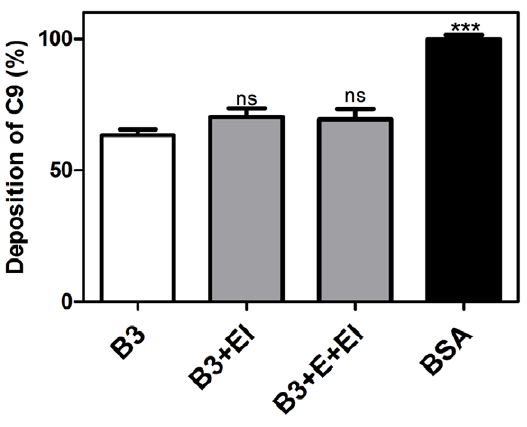
Figure 8. Digestion of SMSB3 by human neutrophil elastase has no effect on C9 deposition. SMSB3 was cleaved with human leukocyte elastase, following which the enzyme was inhibited by addition of N -methoxysuccinyl-Ala-Ala-Pro-Val-chloromethyl ketone. Control reactions without addition of elastase (E) and elastase inhibitor N -methoxysuccinyl-Ala-Ala-Pro-Val-chloromethyl ketone were pre- formed under the same conditions. Mannan was immobilized on microtiter plates and allowed to activate 4% NHS containing 50 m g/ml SMSB3. As a negative control, BSA was used at a concentration of 10 m g/ml. After a 20 min incubation the plates were washed and the deposited C9 was detected with specific antibodies. An average of three independent experiments is presented with bars indicating means 6 SEM. *p , 0.05, ***p , 0.001 by t test (GraphPad Prism).